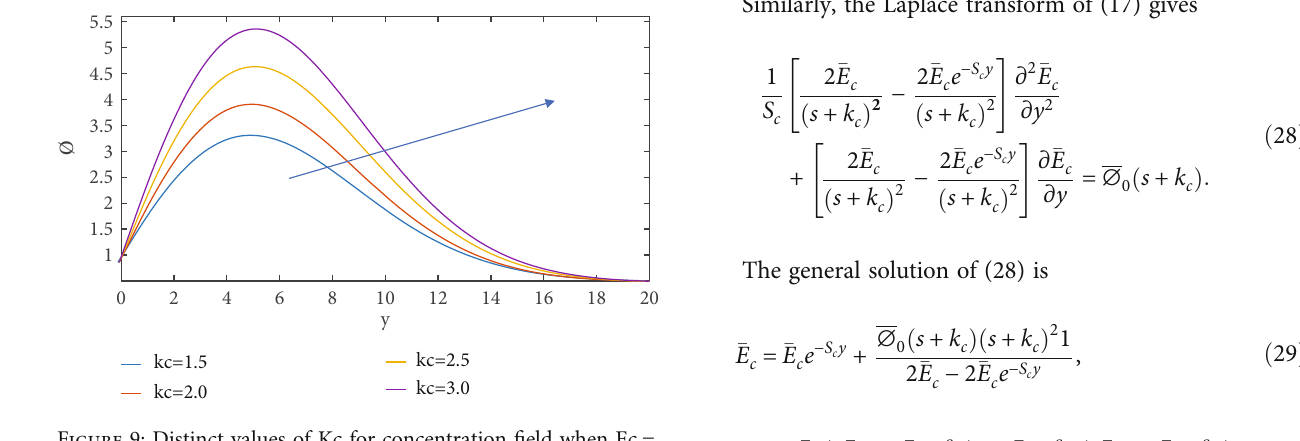
Figure 9: Distinct values of Kc for concentration fi eld when Ec = 0 : 1 , t = 0 : 2 , and Sc = 2 : 01 .